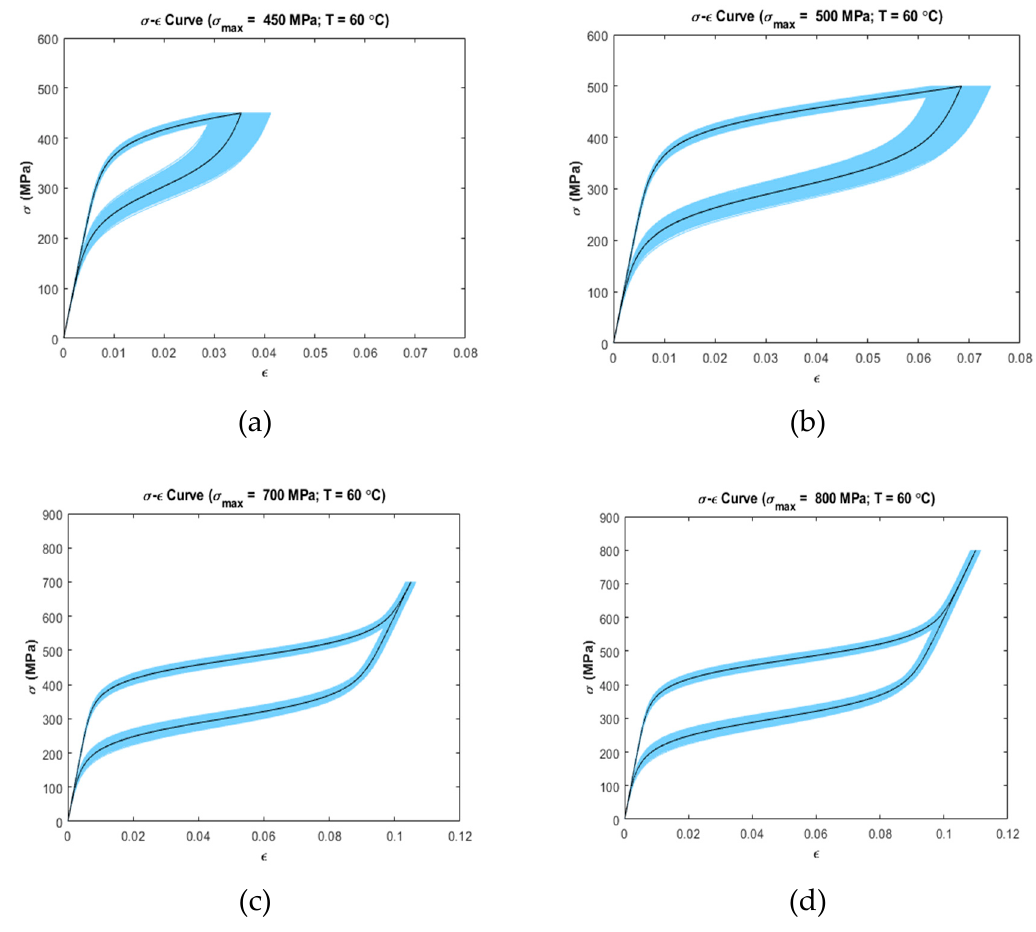
Figure 5. Confidence intervals (5–95 percentile) at simulated temperatures and maximum loading stress (Dark Color shows the deterministic curves): ( a ) T = 60 ◦ C, σ max = 450 MPa ( b ) T = 60 ◦ C, σ max = 500 MPa ( c ) T = 60 ◦ C, σ max = 700 MPa ( d ) T = 60 ◦ C, σ max = 800